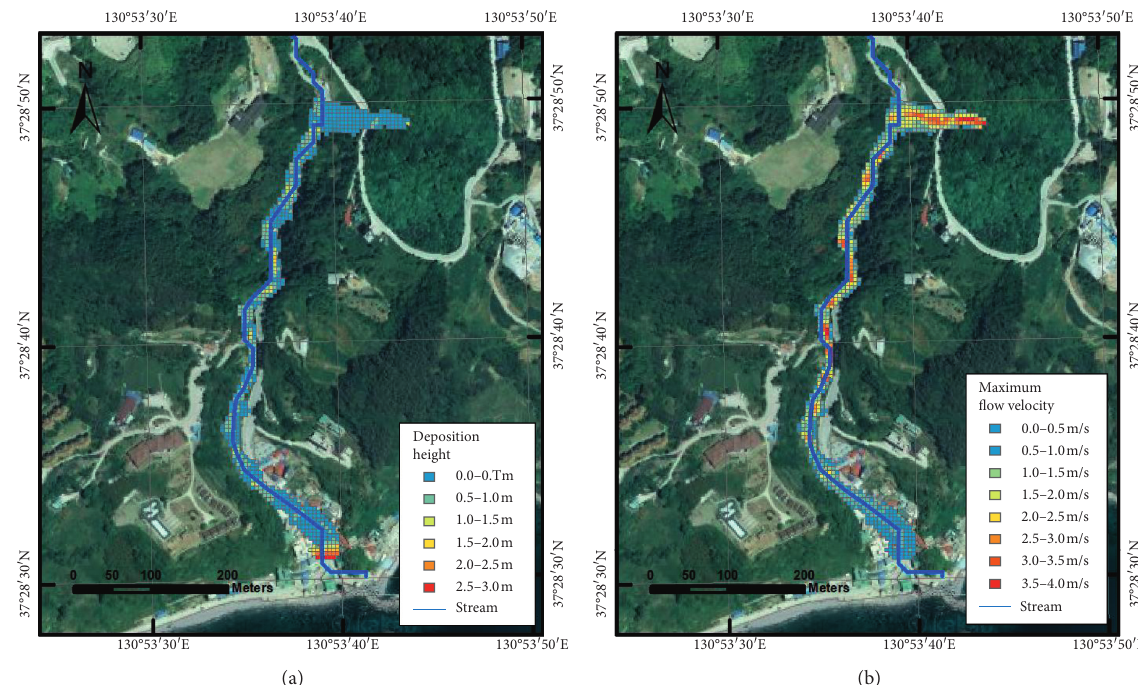
Figure 8: Results of KANAKO-2D numerical analysis for debris flow area: (a) deposition height of debris flow; (b) maximum flow velocity of debris flow.